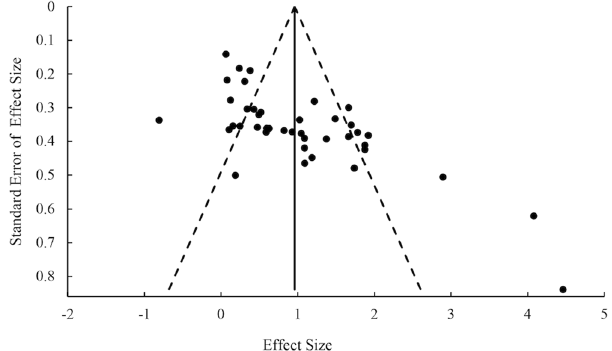
Figure 8. Funnel